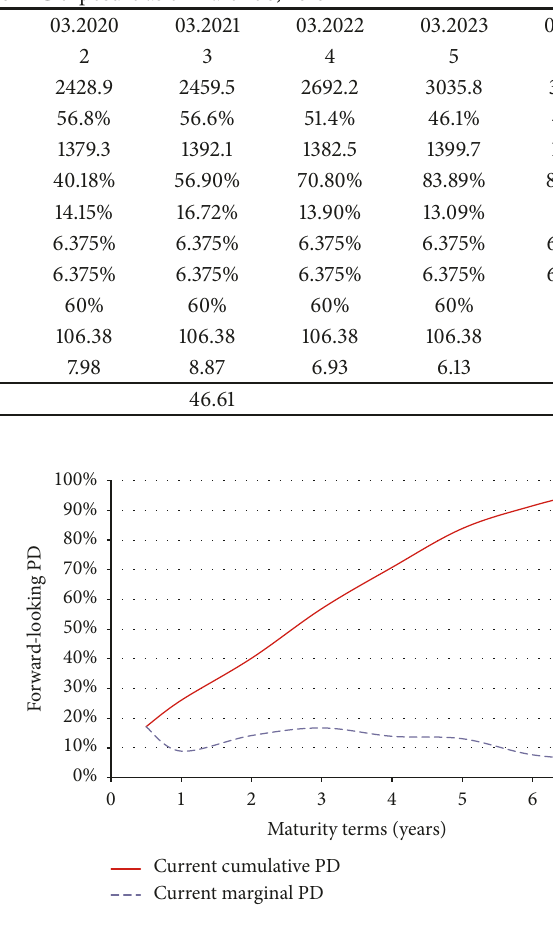
Figure 9: Windstream Services term structure of default risk: current PD